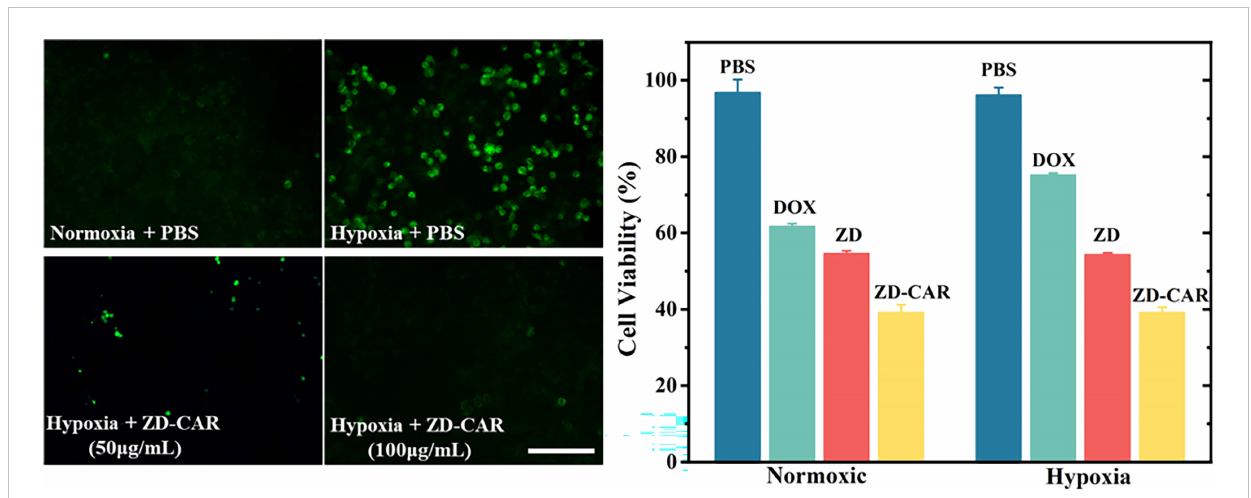
FIGURE 7 Fluorescence images of HIF-1 a (green) in HepG 2 cells incubated with ZD-CAR under normoxic or hypoxic conditions. Scale bar is 100 m m. (Left) and cell viability of different materials under normoxia or hypoxia